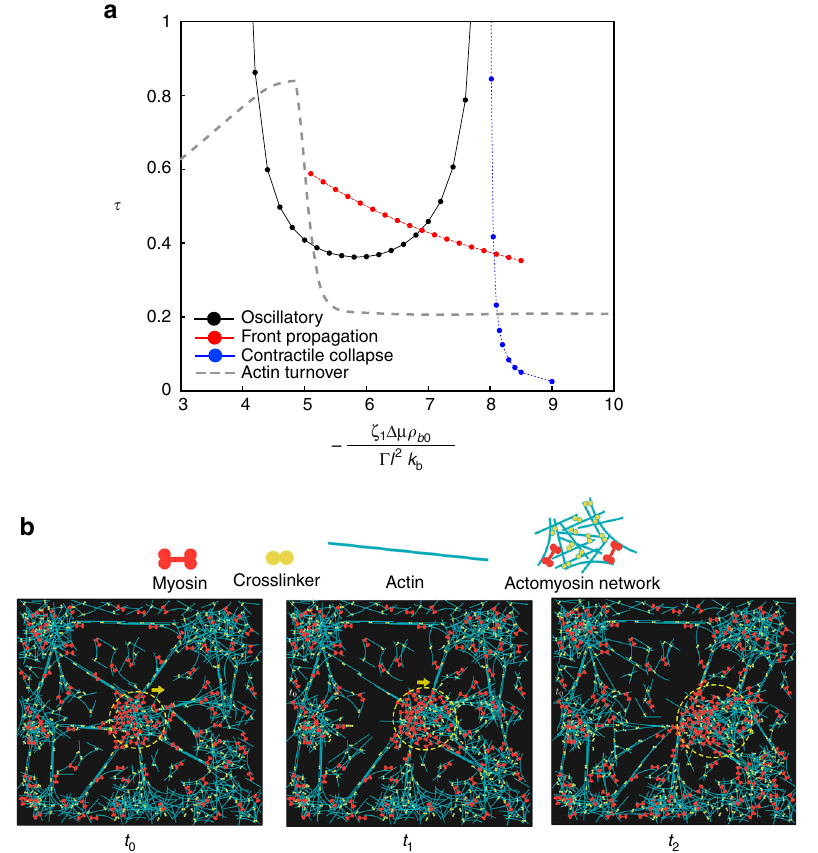
Fig. 7 Enhanced actin turnover results in nonaf fi ne deformation of the elastomer: a Qualitative behavior of the actin turnover time as a function of contractile stress, which is consistent the with data from refs. 31 – 33 . This should be compared with the time scales of oscillation, front propagation and contractile collapse obtained from the af fi ne theory (see, Supplementary Fig. 5). Based on the discussion in the text, we have placed the crossover stress σ ? in the moving regime, thus implying that the crossover to the nonaf fi ne description occurs in this regime. b Schematic showing the intranetwork fl ow of an actomyosin-dense region (enclosed within the yellow circle) resulting from active stress induced unbinding and rapid turnover of the actin in a transient actomyosin